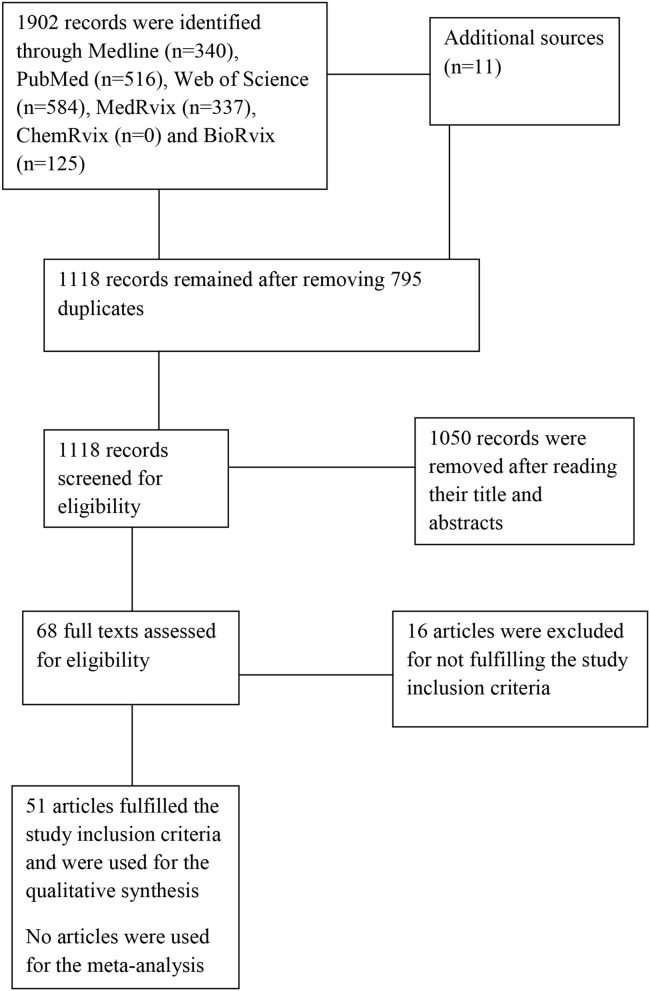
The study flowchart.